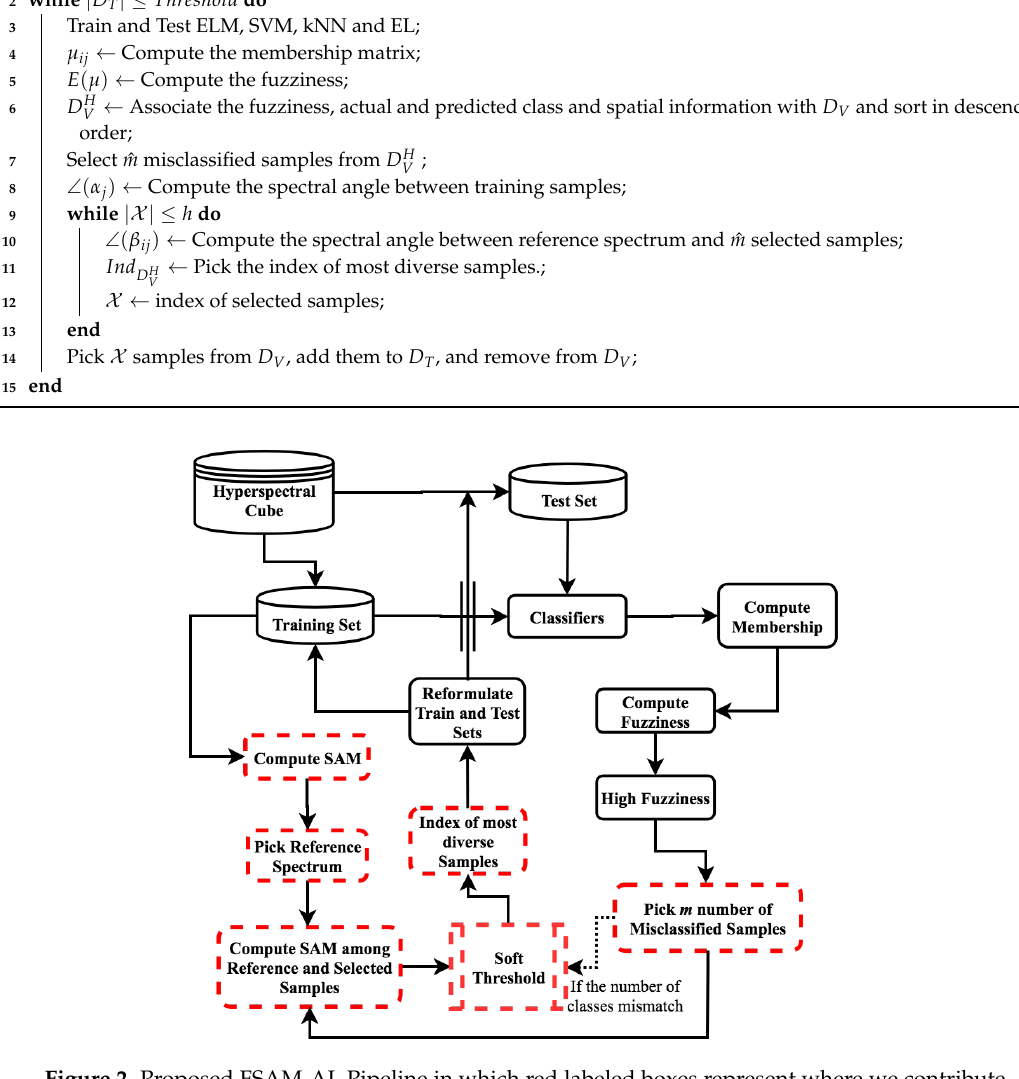
Figure 2. Proposed FSAM-AL Pipeline in which red labeled boxes represent where we